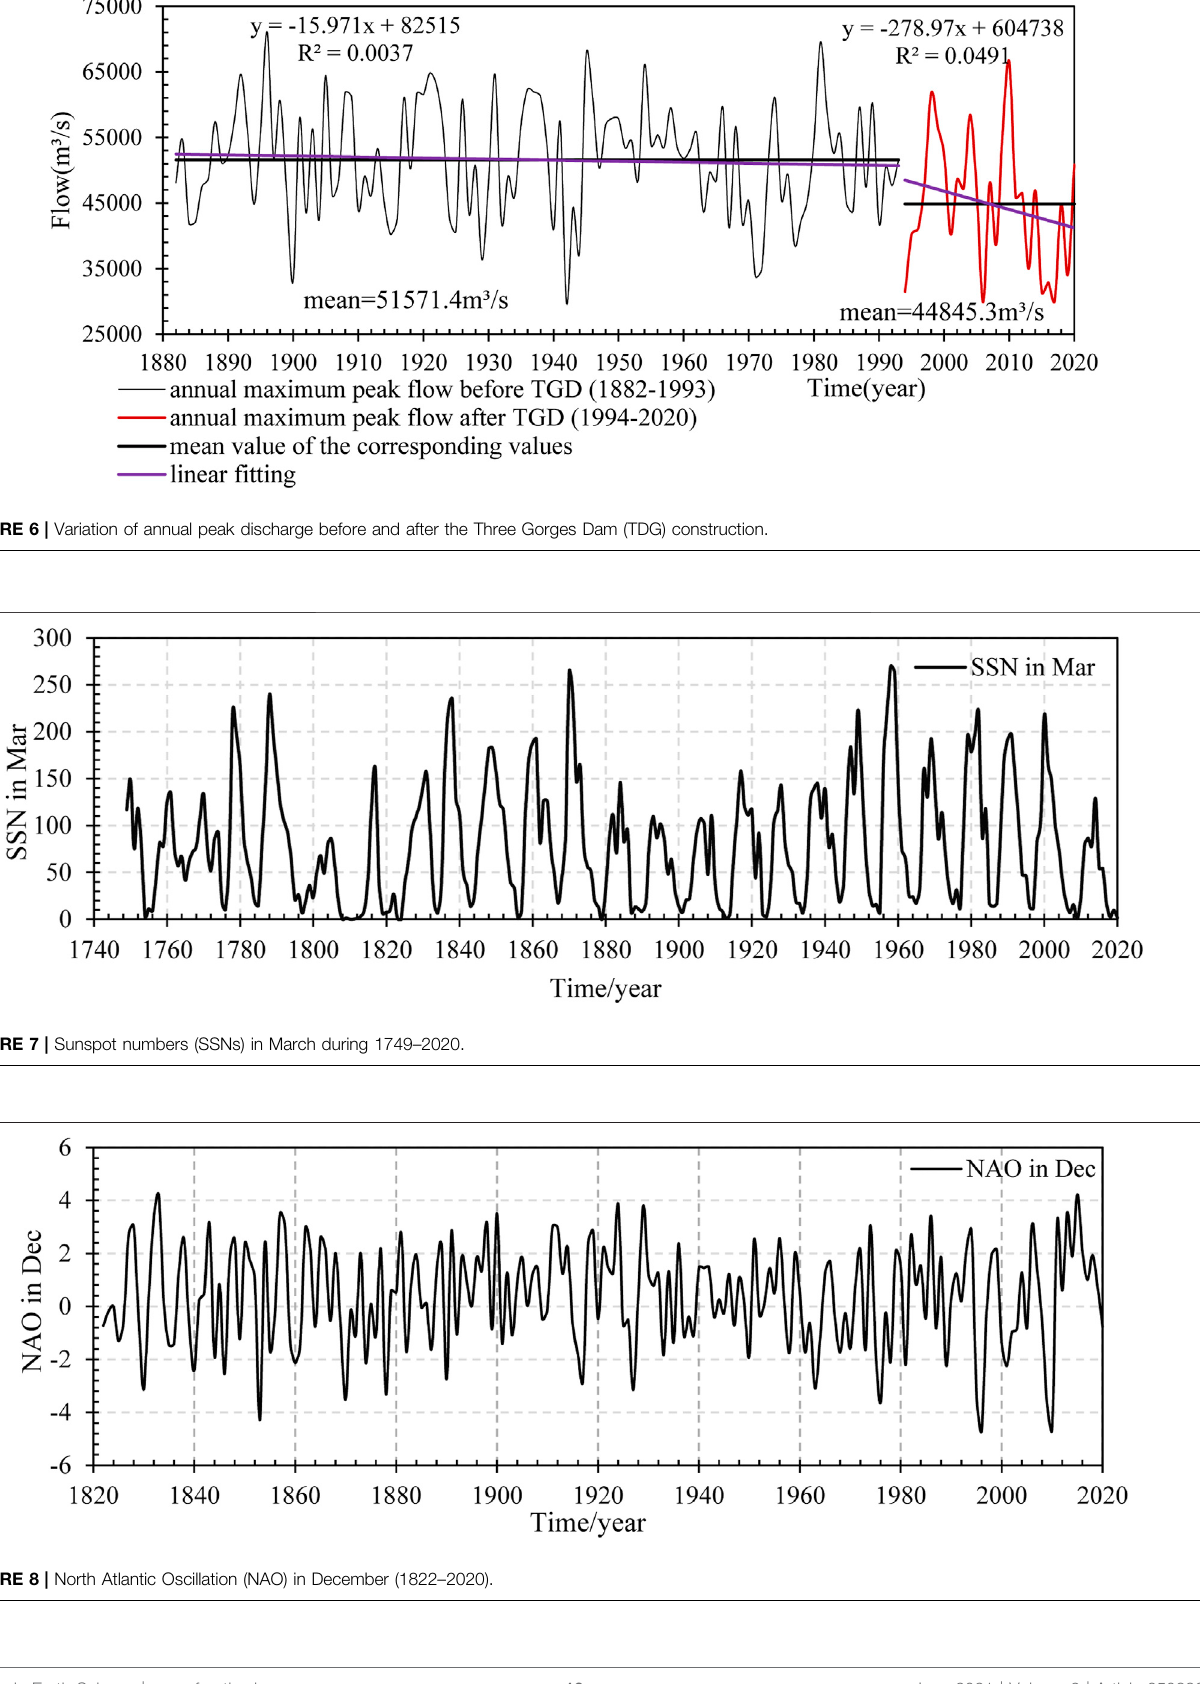
Frontiers in Earth Science |